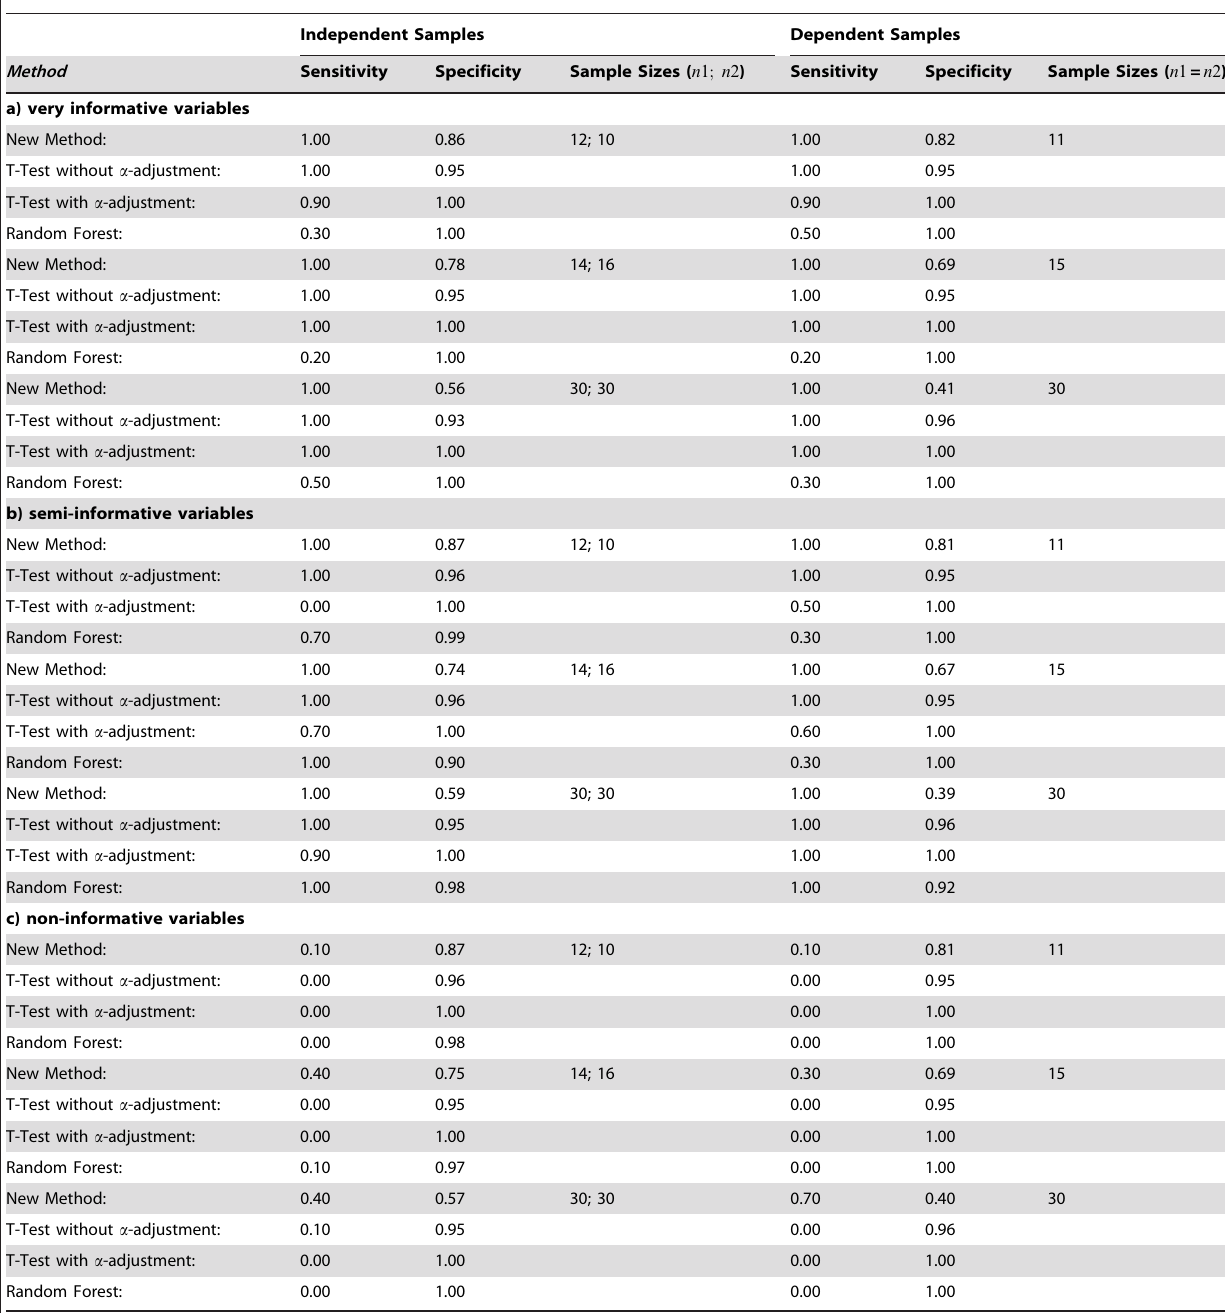
Table 3. Validity of new method compared to alternative